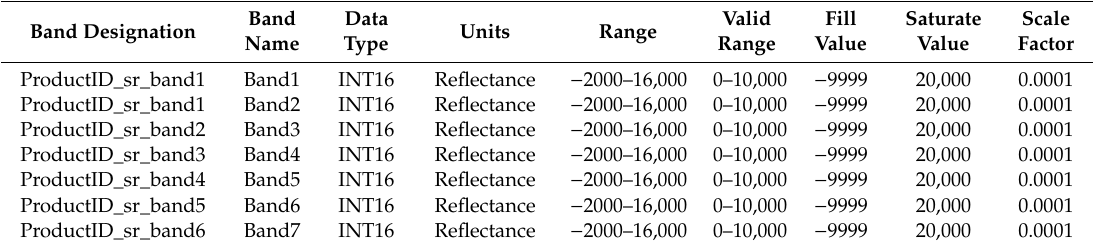
Table 1. Significant features of Landsat 8 surface reflectance (L8SR) data